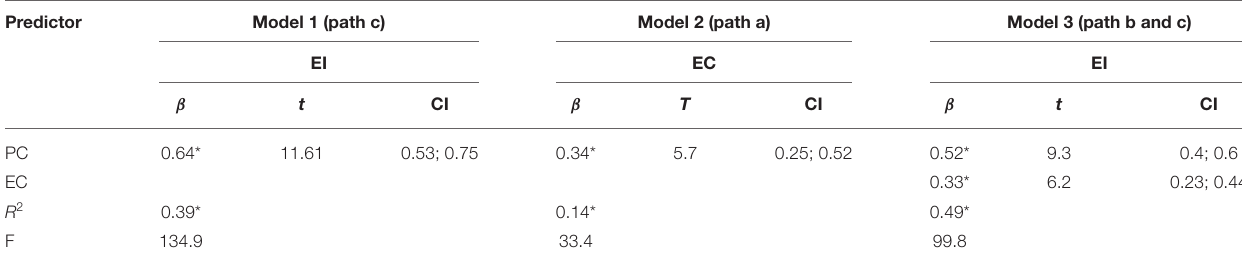
TABLE 2 | Mediating effect of EC between PC and EI using process macro. Predictor